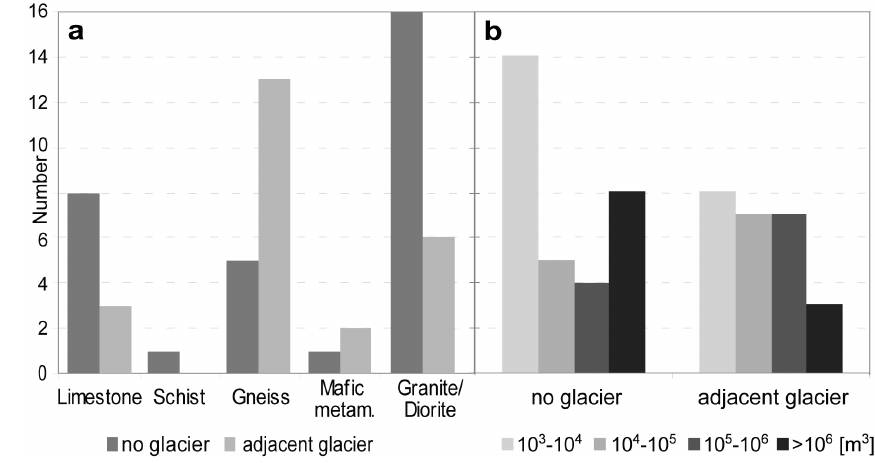
Fig. 10. (a) Glacierization situation at failure time of each rock avalanche event against the lithological classes. (b) glacierization state for the four volumetric classes.